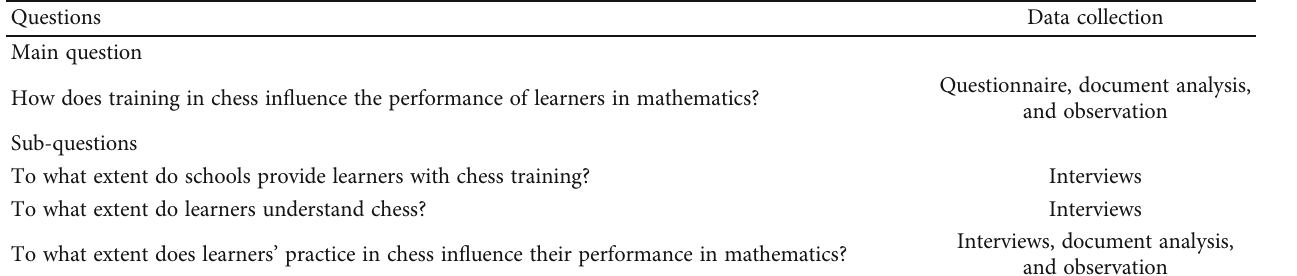
Table 3: Alignment of data collection instruments to the research